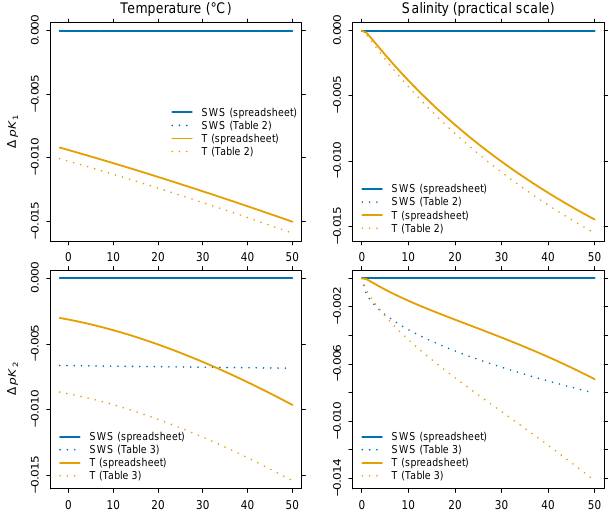
Figure 15. Relative differences between four formulations for p K 1 (top) as well as p K 2 (bottom), i.e., between values computed from four different sets of coefficients from Millero (2010) over ranges of T (left) and S (right). Two sets of coefficients are from Millero’s (2010) Tables 2 and 3, i.e., for the total scale ( T , orange dotted line) and the seawater scale (SWS, blue dotted line). The two other sets, also on the T and SWS scales (solid lines), have greater precision, coming from the spreadsheet used for calculations in the same publication (F. J. Millero, personal communication 2013). For consistent comparison, both SWS curves were converted to the to- tal scale using the standard approach (Millero, 2010, Eqs. 11 and 12) and K F from Perez and Fraga (1987). Curves are shown after subtracting values from the preferred formulation (spreadsheet co- efficients for the SWS scale converted to the T scale).